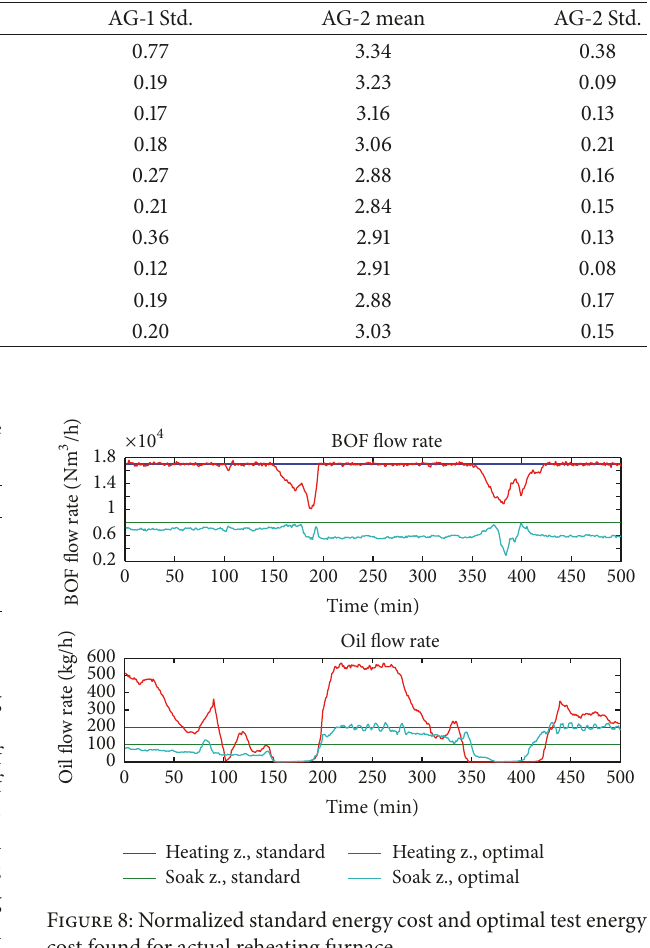
Table 4: Comparison between results of the allowed solutions from AG-1 and AG-2.